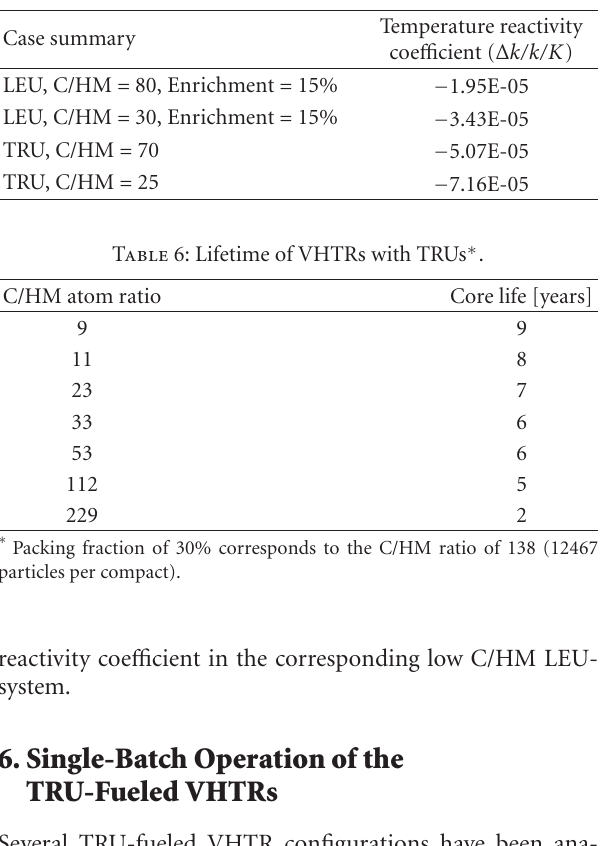
Table 5: BOL isothermal temperature reactivity coe ffi cients of VHTRs with LEU and TRU.